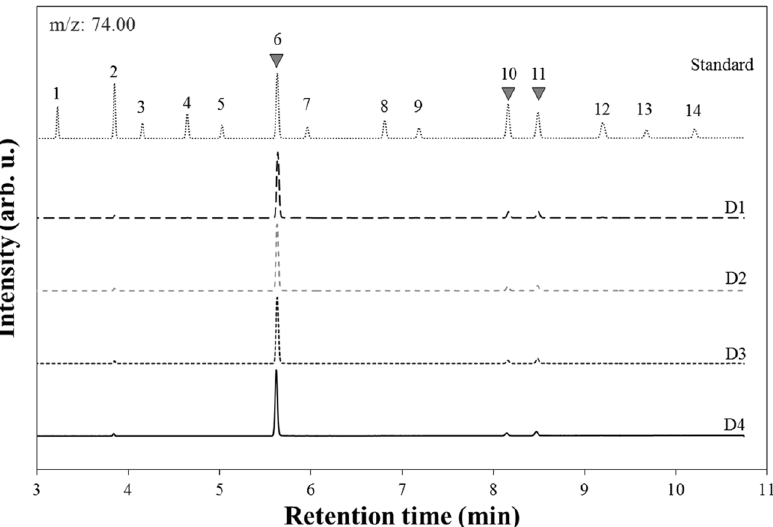
Figure 1. FAMEs in the standard and extracts of the diesel-contaminated soils analyzed by GC–MS in the SIM mode at m/z 74.00. Specific compounds for the peak numbers are listed in Table 2.